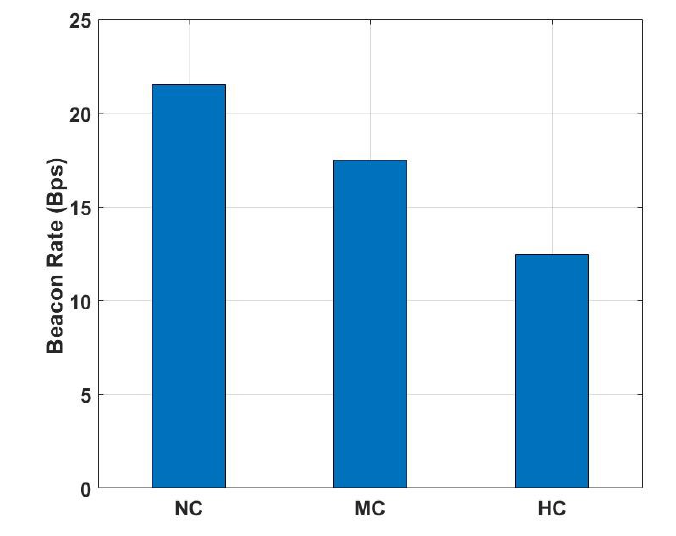
Figure 16. Beacon per second (Bps).